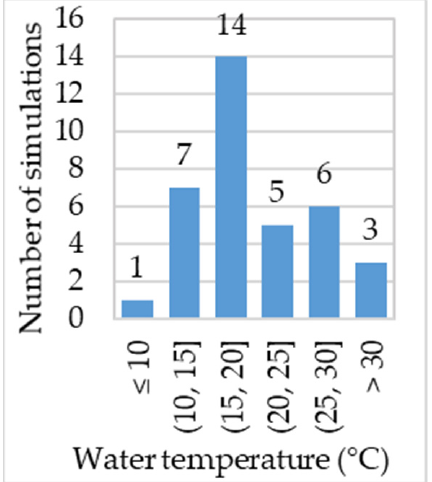
Figure 5. Measured water temperature values during rainfall simulations. Modifications of dripper performance via air flow and vibration were carried out in